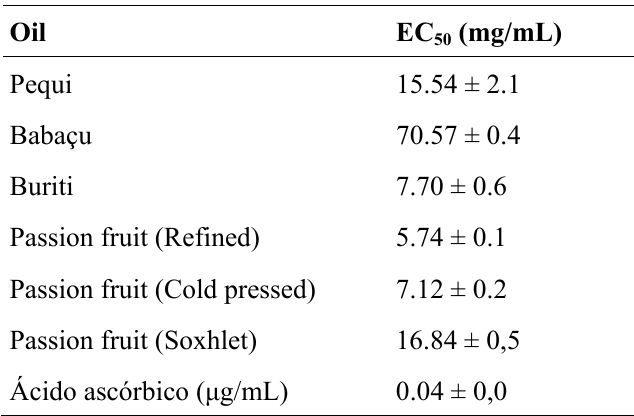
Table 4. Antioxidant activity.